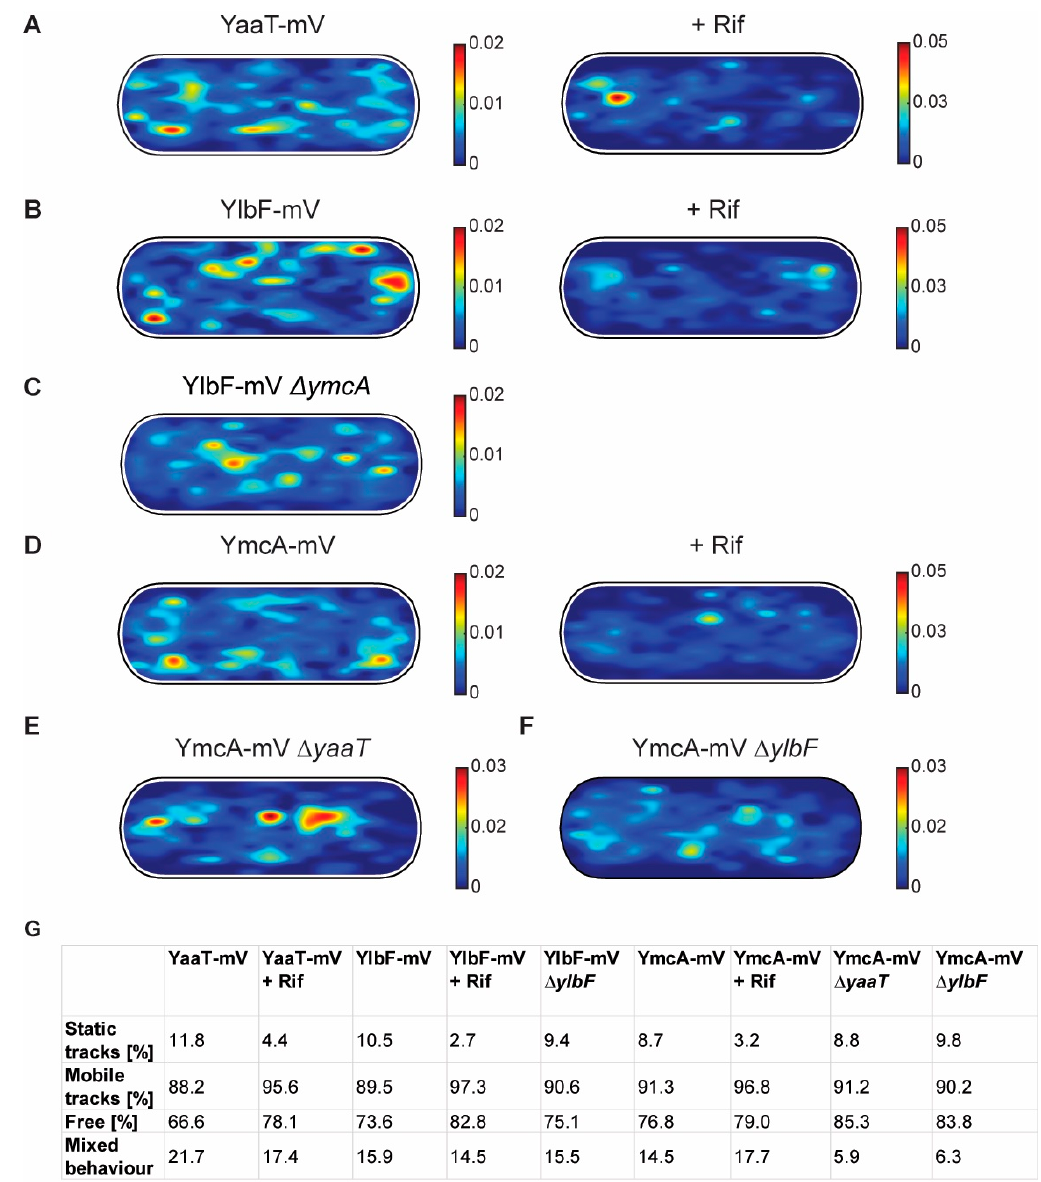
Figure 6. Confinement maps of Y-complex proteins with and without rifampicin, and of YmcA-mV in the absence of YaaT or YlbF. ( A – F ) Plots of heat map of confined tracks, projected into a standardized B. subtilis cell. Constructs as indicated above the panels. ( G ): Overview of ratios between static and mobile tracks.